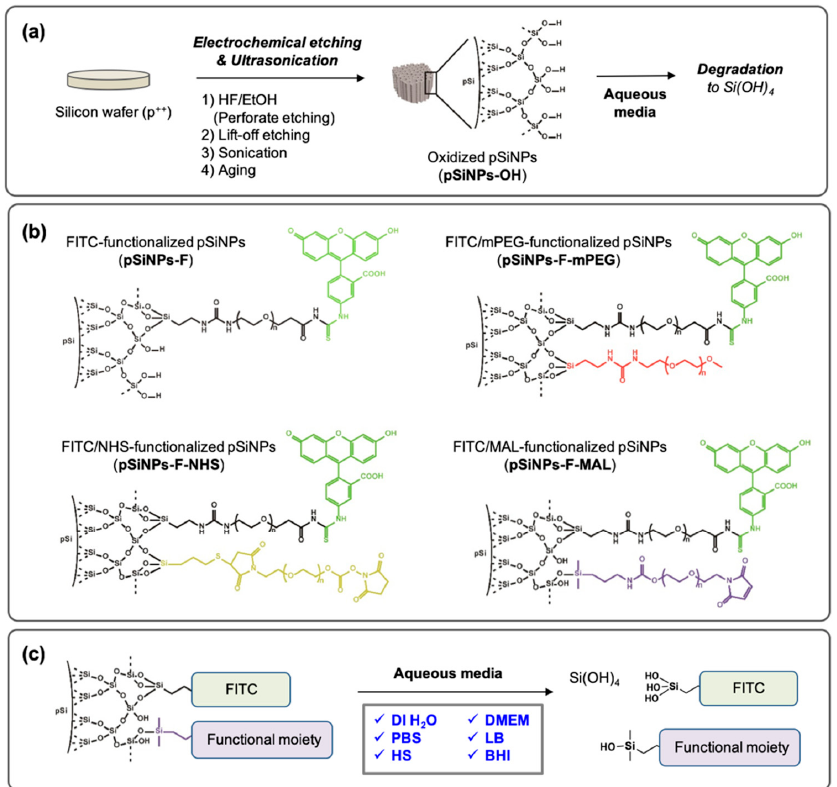
Figure 1. ( a ) Scheme for the preparation of oxidized porous silicon nanoparticles (pSiNPs). ( b ) Chemical structure of the pSiNPs samples used in this study. ( c ) Scheme for the degradation of the pSiNPs samples in aqueous media.